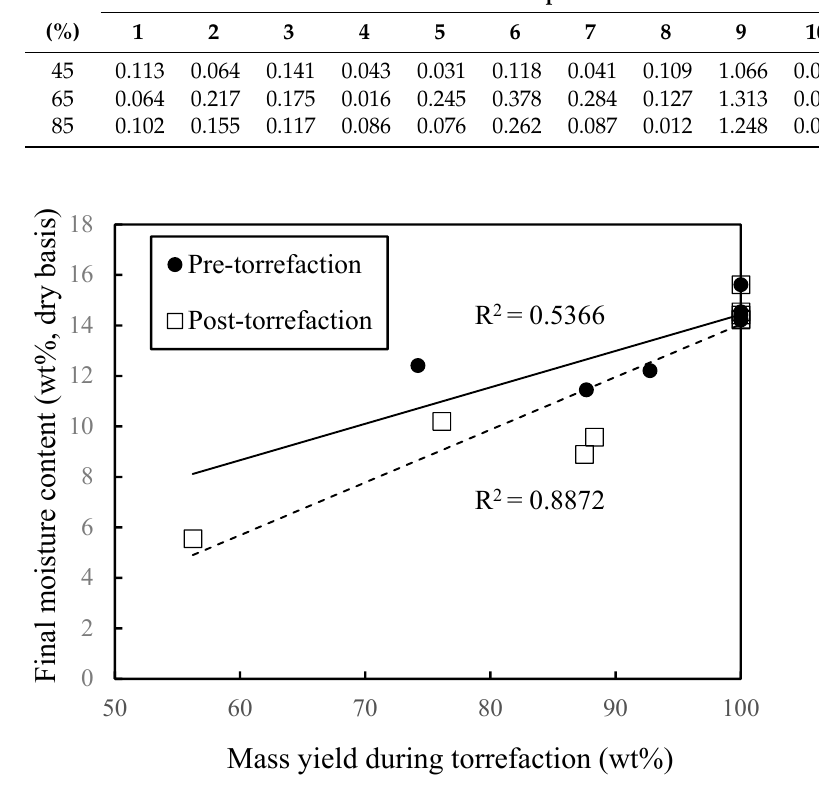
Figure 3. Relationship between the mass yield during torrefaction and the final moisture content of the pellets at 85% RH. Mass yield of 100% refers to normal pellets.